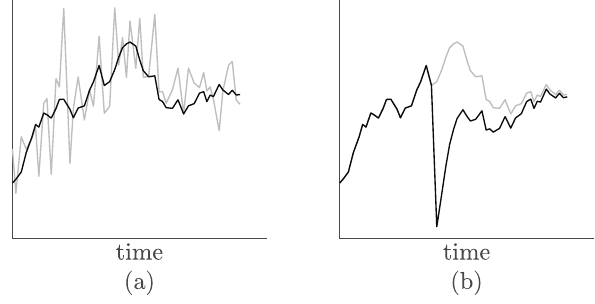
Figure 1. ( a ) The dark line is an illustration of a one-dimensional OU process. The lighter line corresponds to the same OU process, but with additional measurement error. ( b ) An OU process that has been disrupted by an external event (the larger spike in the middle). For reference purposes, the trajectory that would be observed if there was no disruption is depicted as well